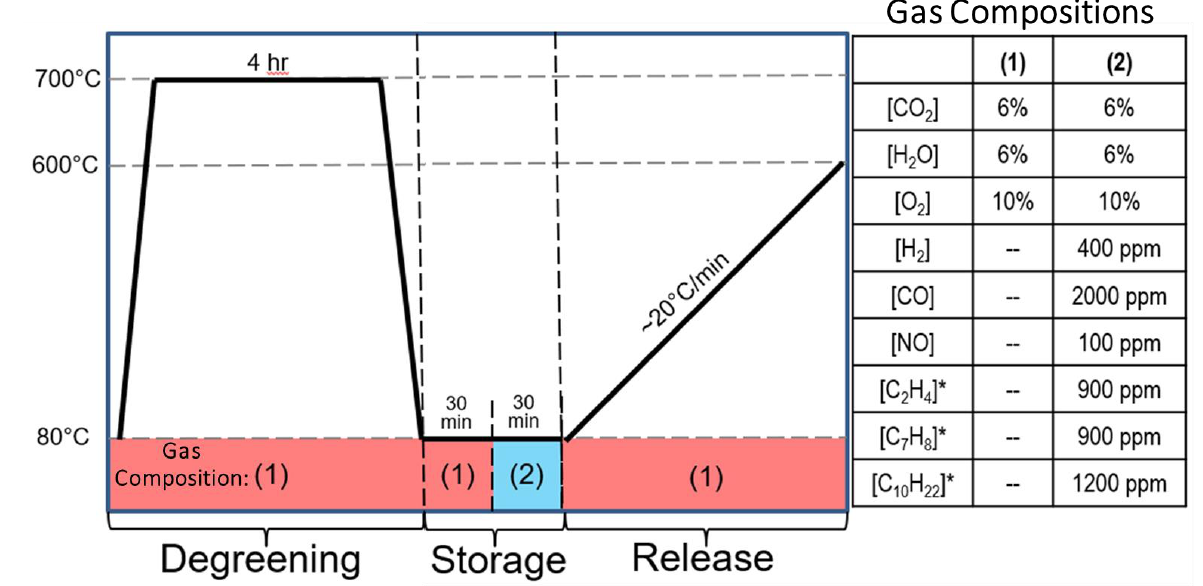
Figure 8. Storage and release characterization protocol (left) and gas concentrations (right). *—hydrocarbons are listed on a C 1 basis.